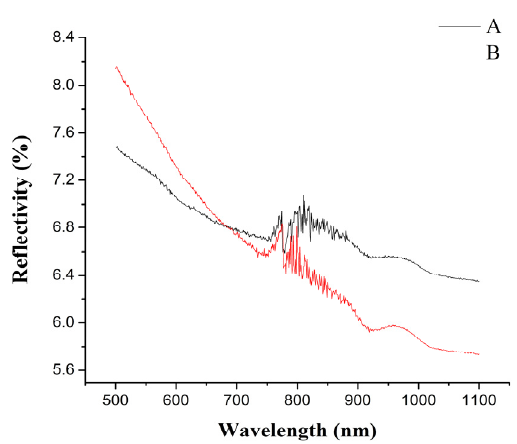
Figure 7. The reflectivity of PP at different wavelengths before and after grafting modification.